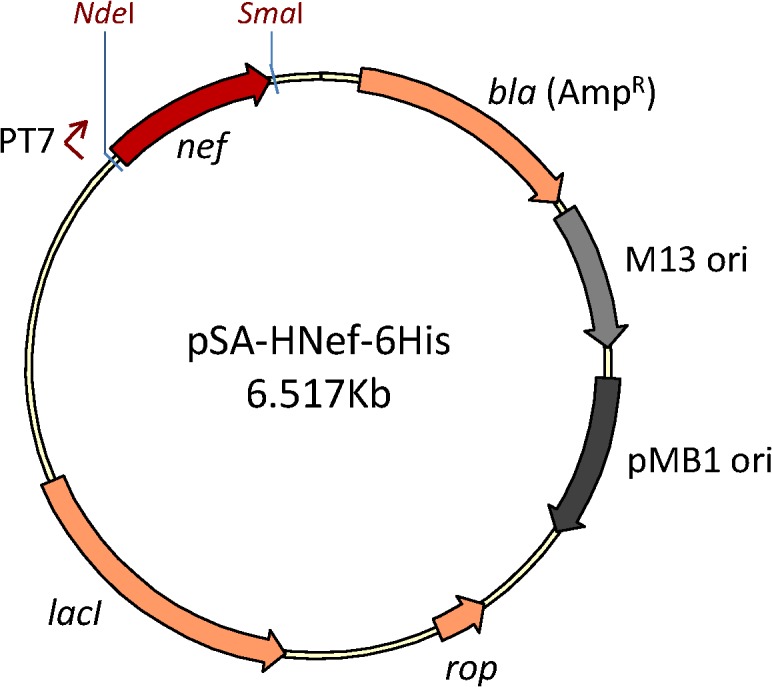
Schematic representation of expression vector pSA-HNef-6His.The nef gene was PCR amplified from pNL4.3 plasmid, restricted with NdeI/ SacI, and ligated into pSA-6His vector at the same sites.